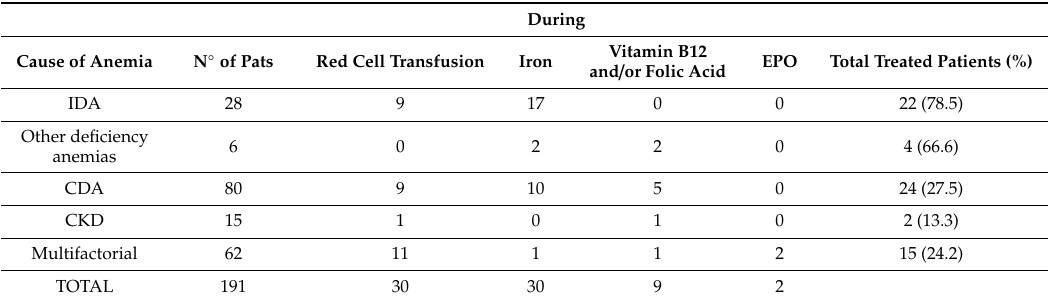
Table 3. Anti-anemic treatment adopted in our patients before and during hospitalization.